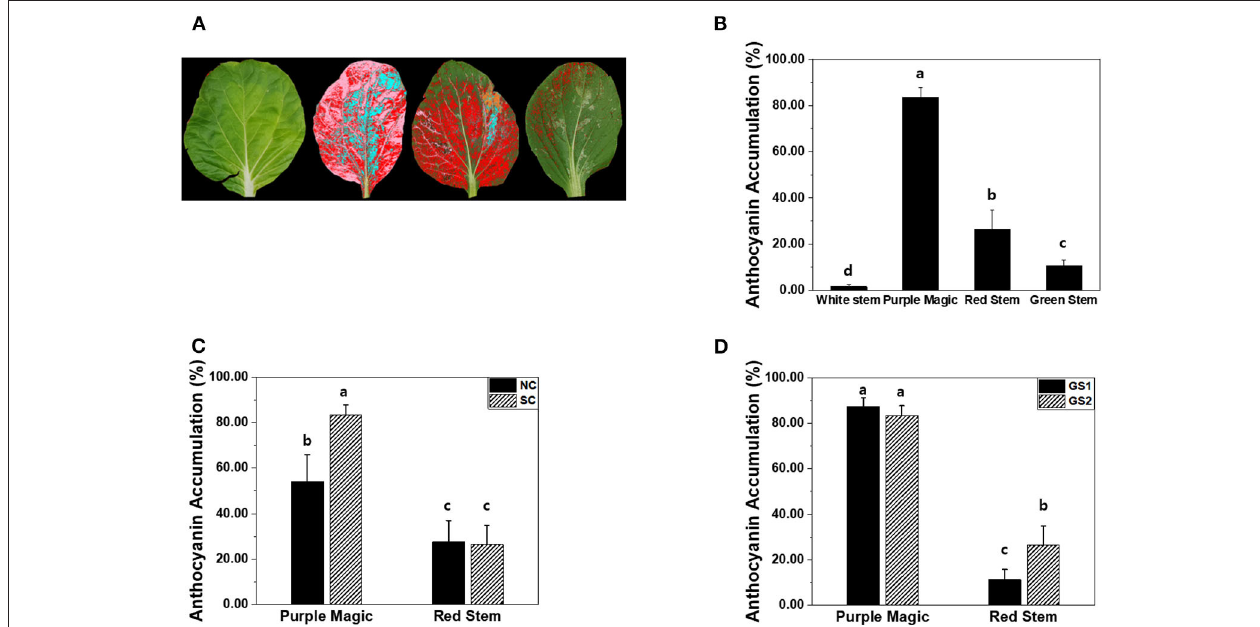
FIGURE 4 | (A) The representative image of four different bok choy cultivars (from the left white stem, purple magic, red stem, and green stem) for leaf color analysis. (B) Comparison of anthocyanin accumulation (%) obtained by leaf color analysis among four cultivars, bok choy. (C) AT accumulation (%) of purple magic and red stem by non-stimulation (NS) and stimulation (CS) conditions. (D) AT accumulation (%) of purple magic and red stem by cultivation period for 2 weeks (GS1) and 4 weeks (GS2). These data were obtained from the second experiment described in the Materials and methods section. Means with a different letter are significantly different at P ≦ 0.05, using Fisher’s LSD analysis.